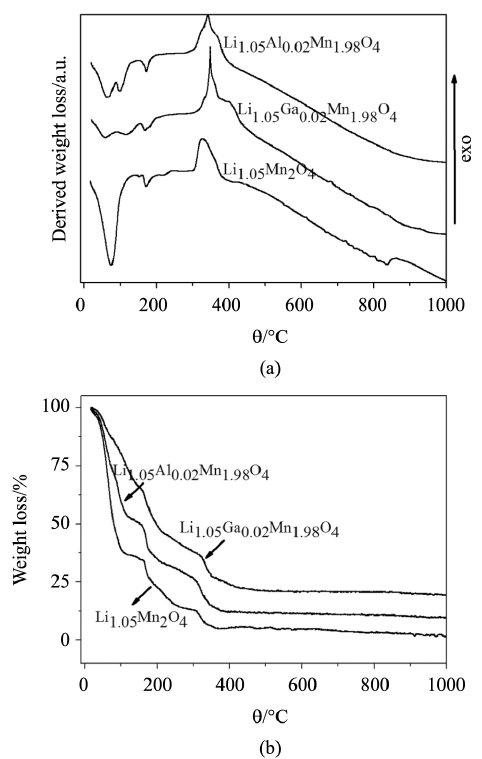
Figure 1. DTA (a) / TGA (b) curves of the precursor gel of Pechini